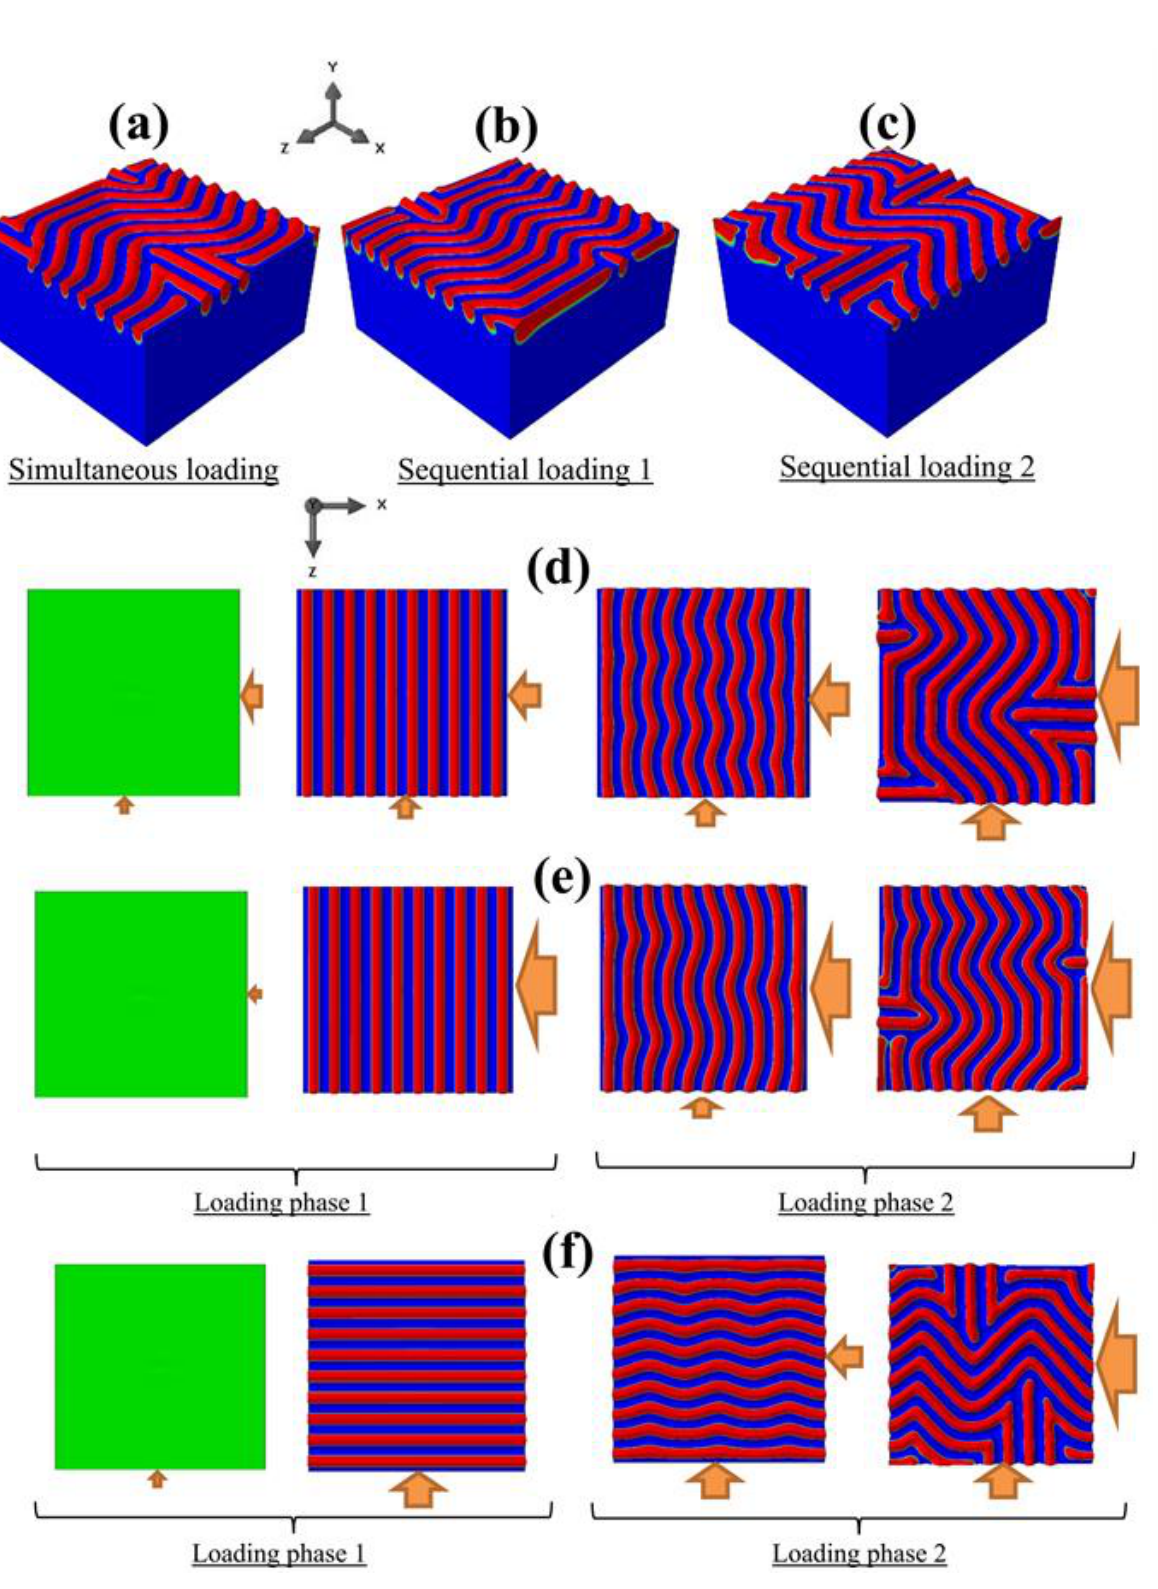
Figure 6. Snapshots of the simulated wrinkling patterns for BR = 0.7 and e xx / e cr ∼ = 3.50, for the case of ( a , d ): simultaneous loading, ( b , e ): sequential loading 1, and ( c , f ): sequential loading 2. The wrinkling configurations at the end of each simulation are presented in ( a – c ). The evolution of the wrinkling patterns (starting from a flat surface until reaching the target strains) are shown in ( d – f ). The directions of the applied displacements are also schematically